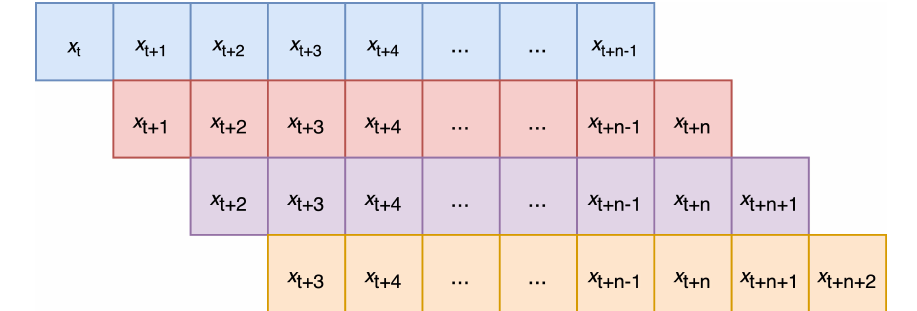
Figure 2. Illustration of n -gram feature vectors.